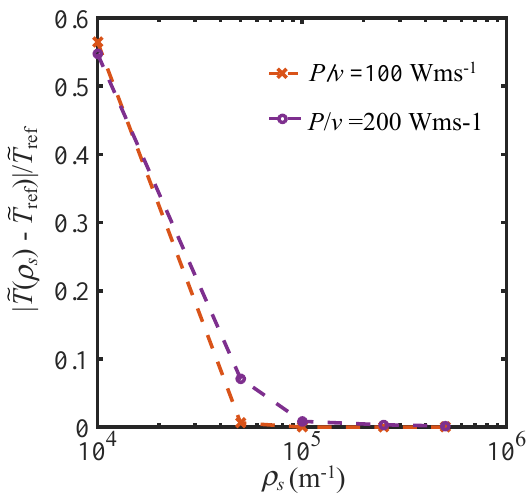
Figure 4. The temperature convergence of ˜ T as a function of the source density ρ s .